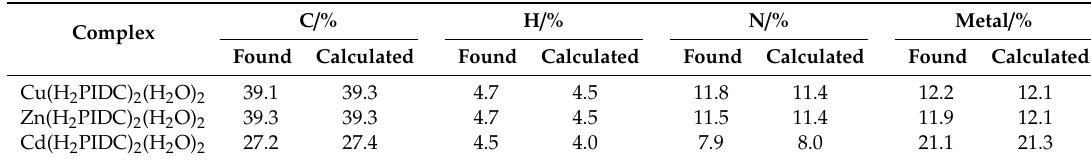
Table 1. Elemental analysis results for the precipitated complexes. Cu, Zn, or Cd (Metal%) were determined by ICP-OES.